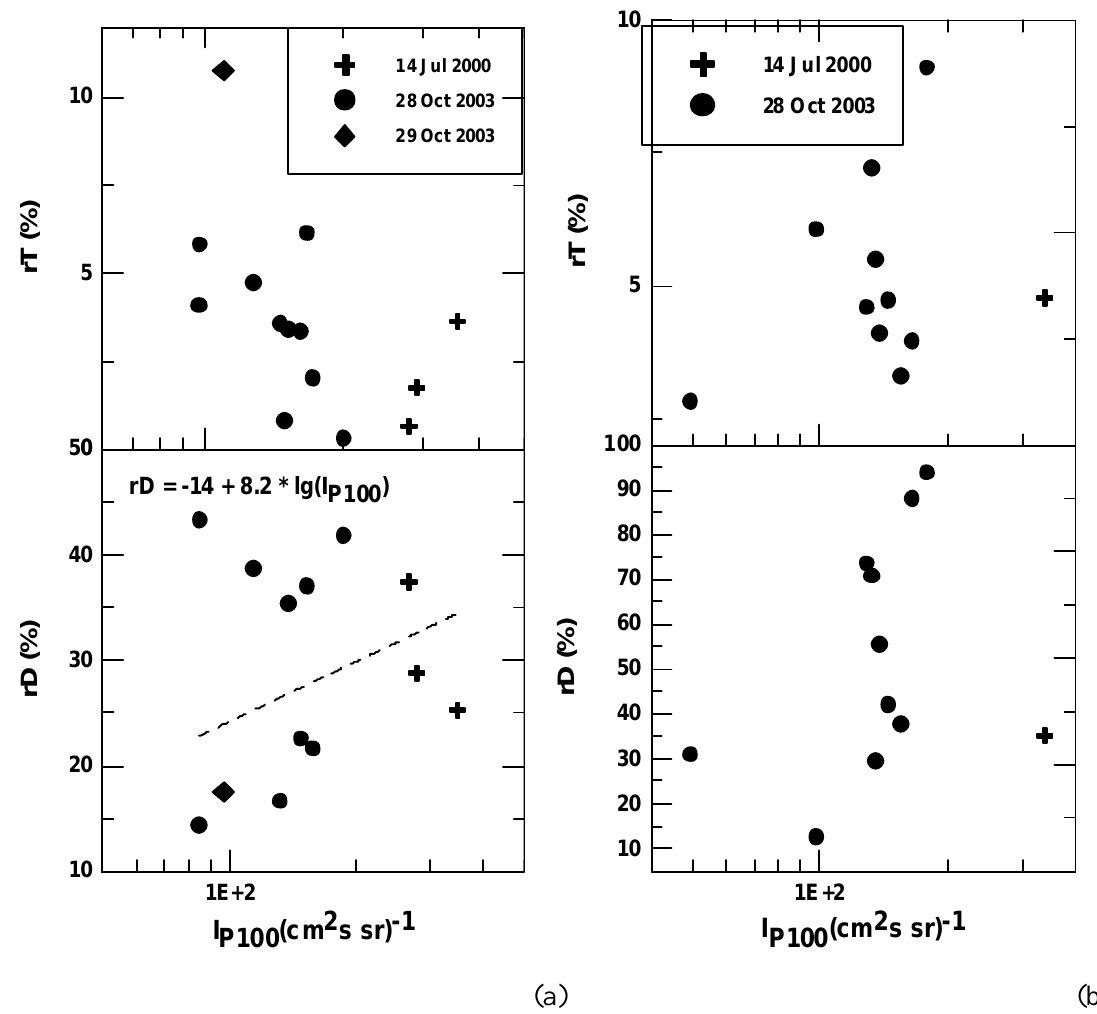
Figure 10. Relative change of the topside ionospheric temperature (upper panels) and ion density (lower panels) versus >100 MeV SEP fluxes at the sunlit (a) and the nightside (b) hemispheres.